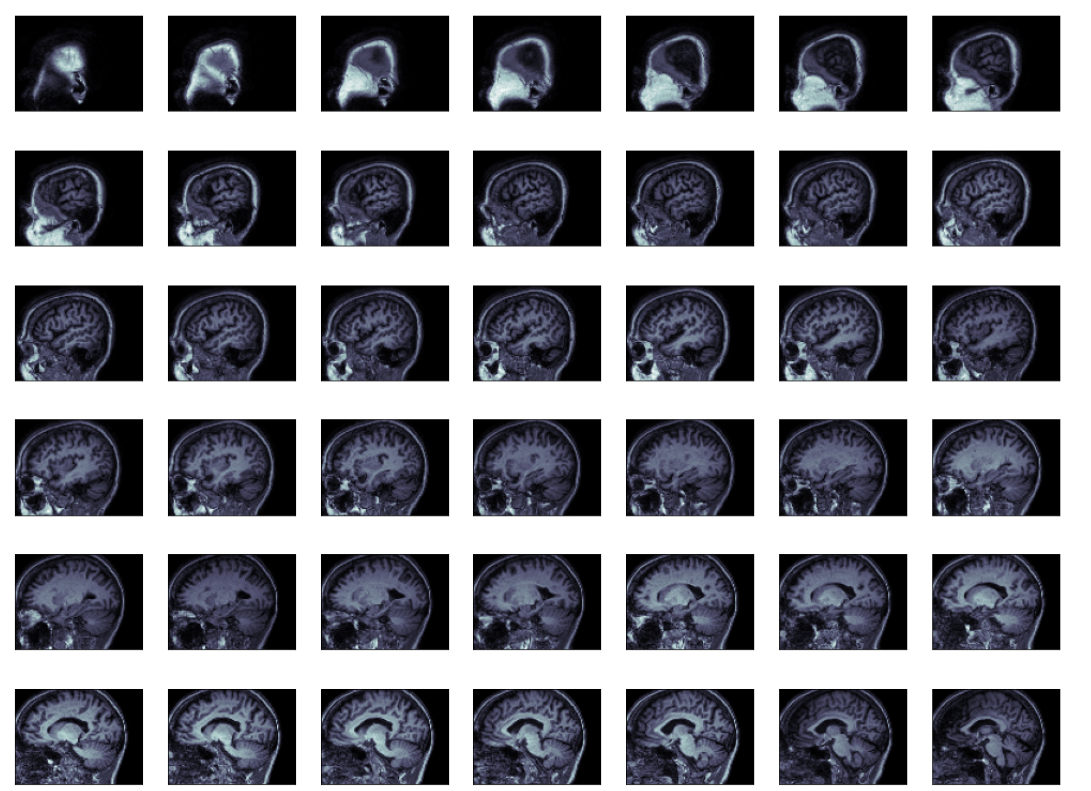
Figure 2. Processed volumetric data from a subject’s MRI (extract of the processed